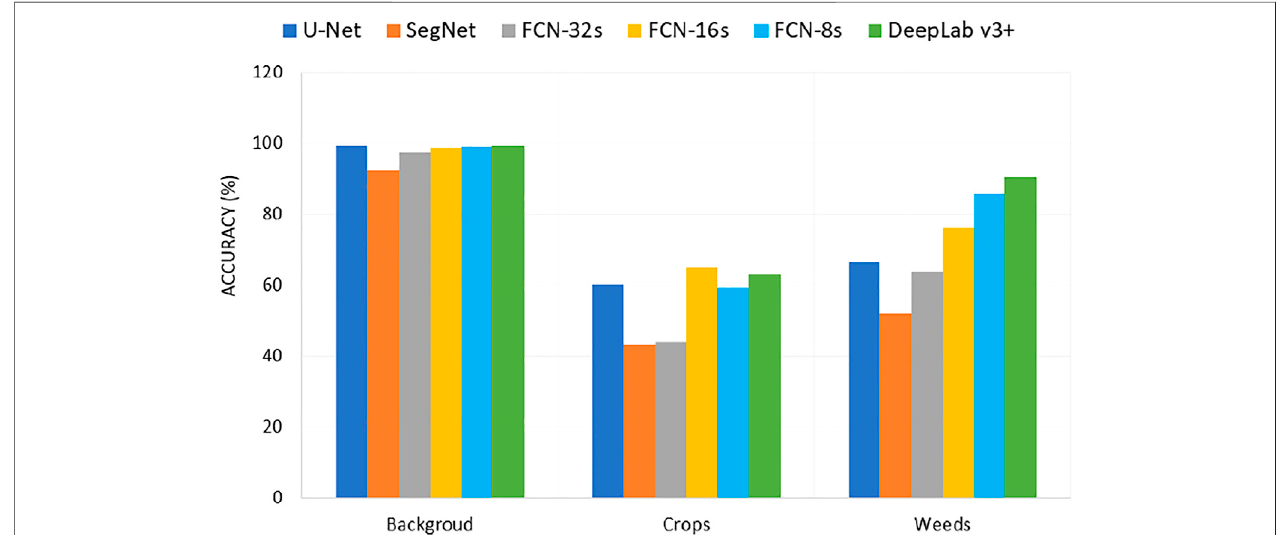
FIGURE 9 | Segmentation results for each of the individual classes for the CWFID dataset.